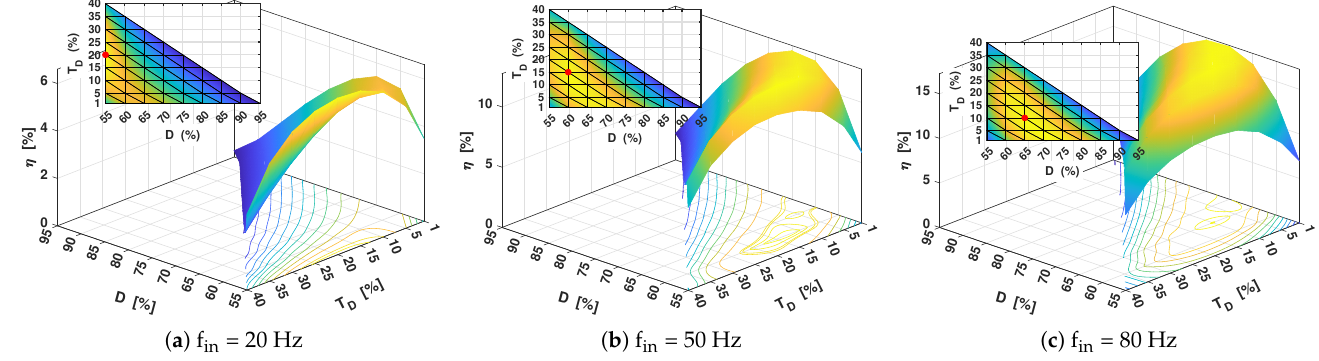
Figure 11. Mapping of the RMS power efficiencies with respect to Duty Cycle (D) and Time Delay (T D ) at different input voltage frequencies (f in ). The insets show the top view of each surface, while the red dots point out the